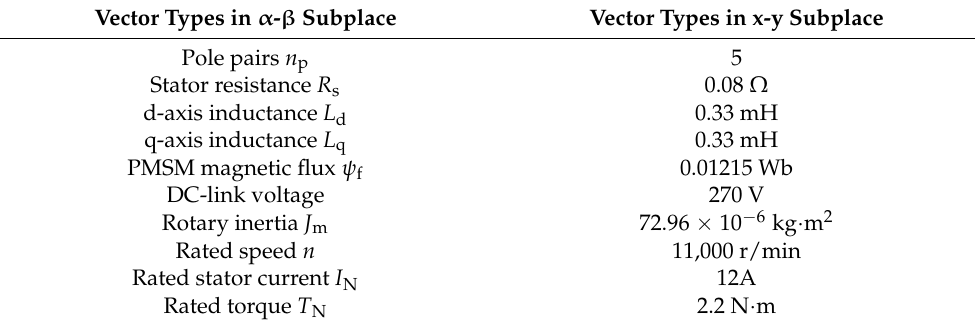
Table 4. Detail parameters of the dual three-phase PMSM.